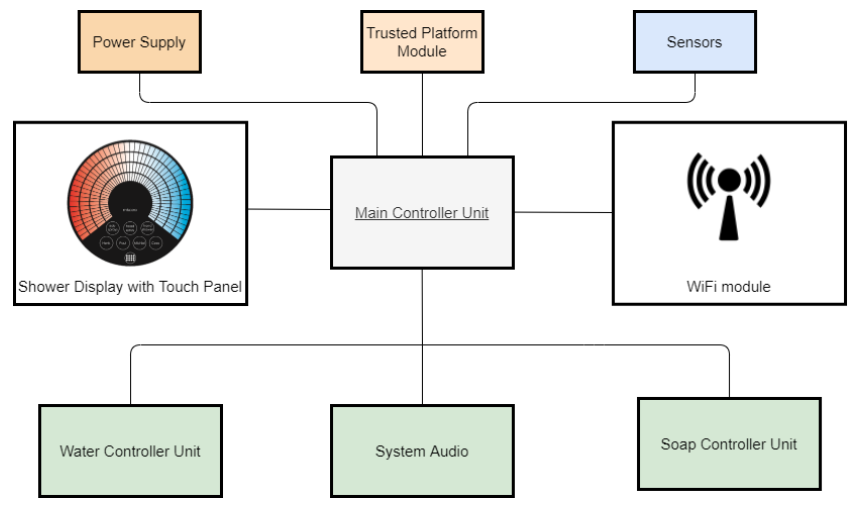
Figure 5. A concept of the main controller unit of the interactive shower